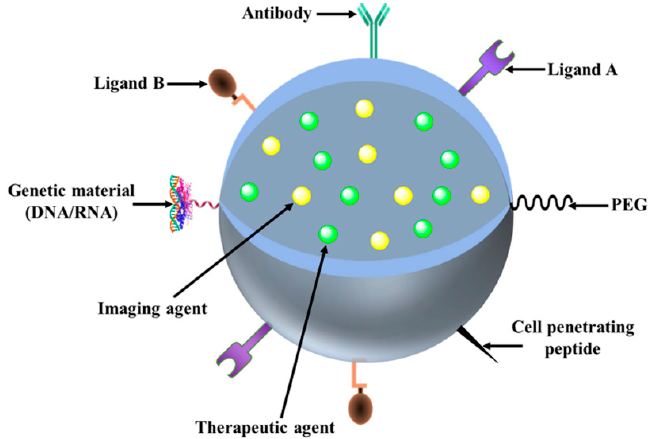
Figure 4. Illustration depicts diagnostic/imaging agent and therapeutic agent consist in a single NPs system as cancer